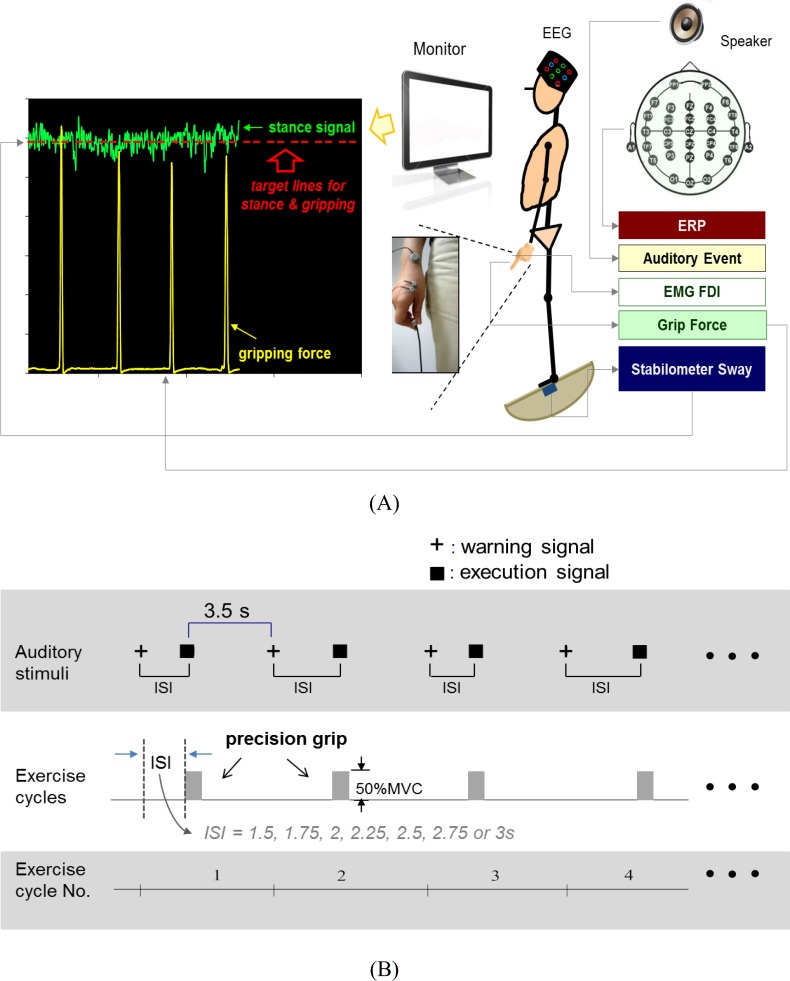
Diagram of study design.(A) Diagram of experimental setup and recordings of physiological data. (B) A schematic illustration of the auditory stimulus paradigm for the dual task (concurrent postural and force-matching tasks). Warning signals (+) to catch the subject’s attention were presented before execution signals (■), at which the subjects started a precision grip for force matching. The interval between the warning and the execution signals, or inter-stimulus interval (ISI), was randomized. A fixed interval of 3.5 seconds separated the execution signal and the next warning signal.